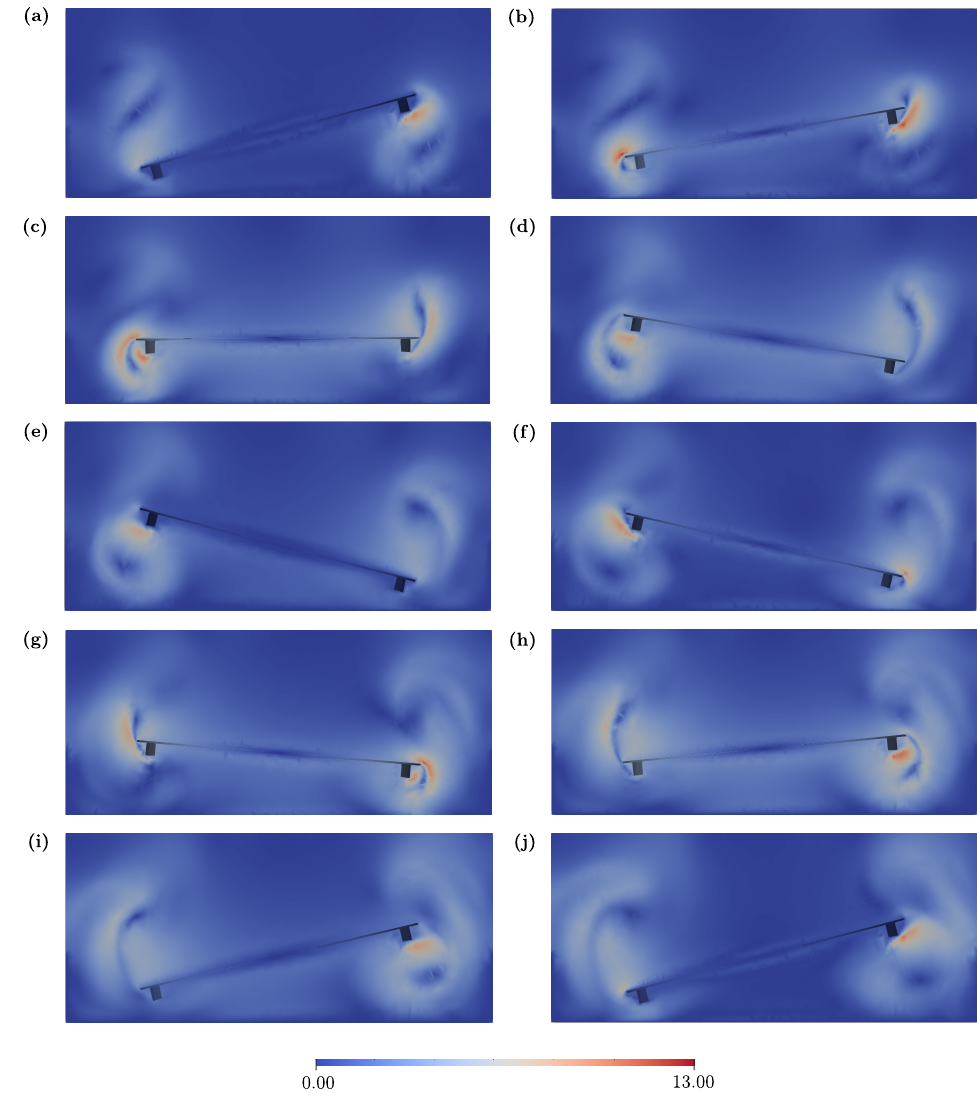
Figure 7. Magnitude of fluid velocity [m/s] for Micromirror 1 in a section generated by the e 2 − e 3 plane passing through the centre of the box for α = 16.60 ◦ . The plots refer to various instants along the period: T p /10 ( a ), T p /5 ( b ), 3 T p /10 ( c ), 2 T p /5 ( d ), T p /2 ( e ), 3 T p /5 ( f ), 7 T p /10 ( g ), 4 T p /5 ( h ), 9 T p /10 ( i ), and T p ( j